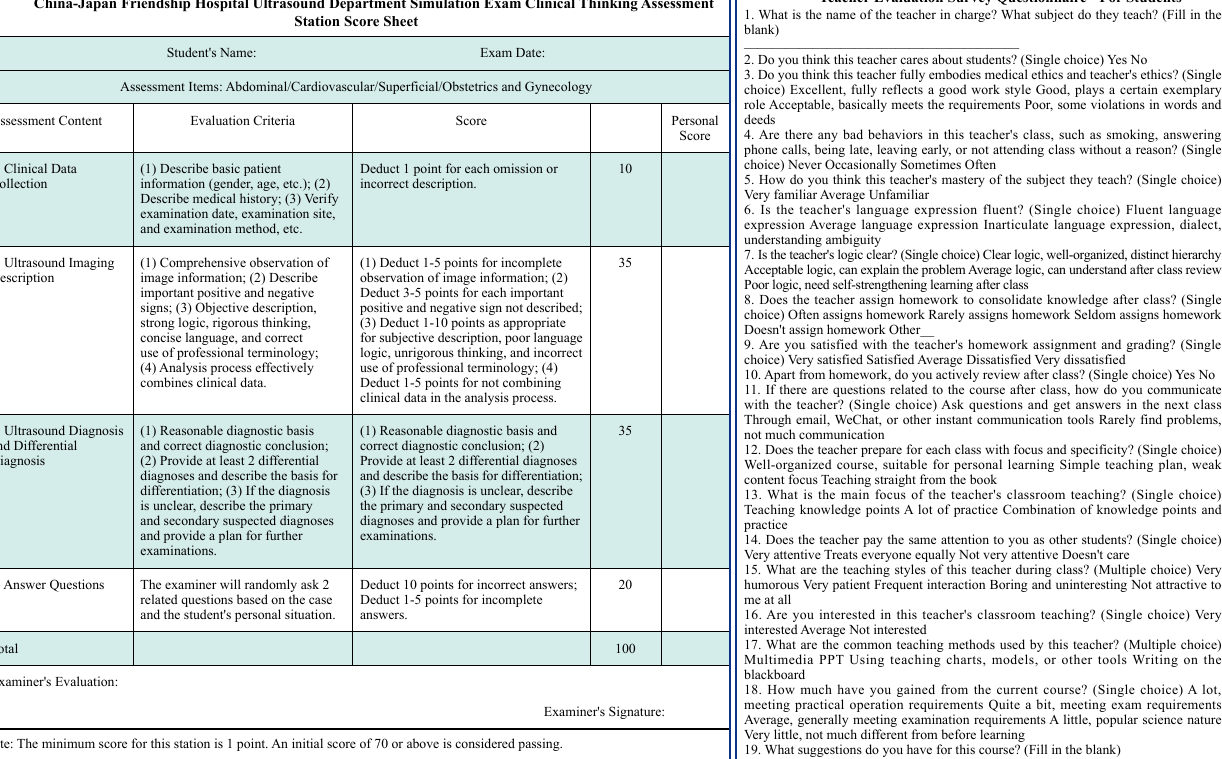
Figure 1 The two-way assessment and evaluation tables for a